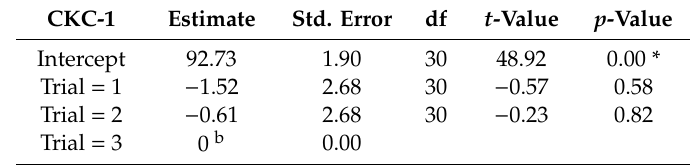
Table 2. Significant di ff erences among mean scores obtained per trial in CKC-1. CKC-1 Estimate Std. Error df t -Value p -Value Intercept 92.73 48.92